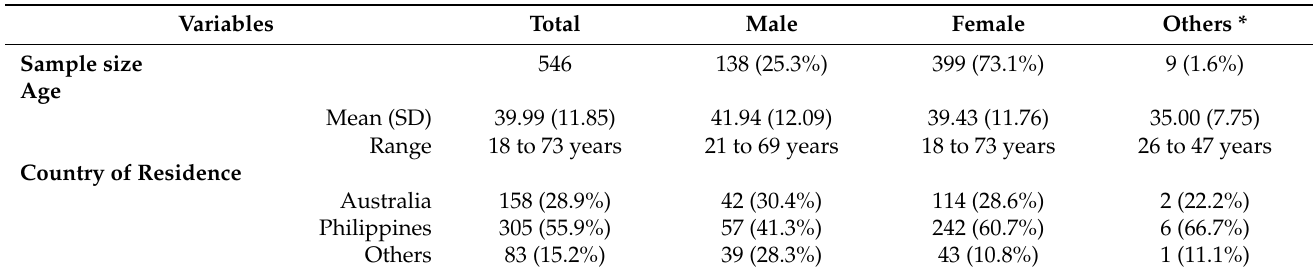
Table 1. Characteristics of the